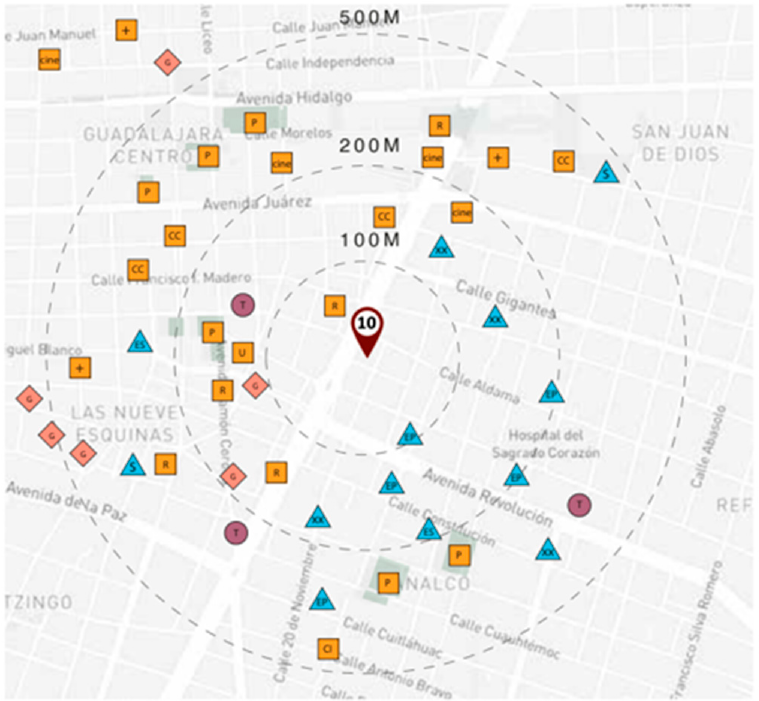
Figure 9. Example of analysis at city scale: urban context nearby study case number 10 “XX de Noviembre”, where triangles indicate places related to reproductive dimension (markets, play- grounds, schools), squares are related to the personal dimension (restaurants, parks) and circles are related to the productive dimensions (offices, enterprises). Source own elaboration.